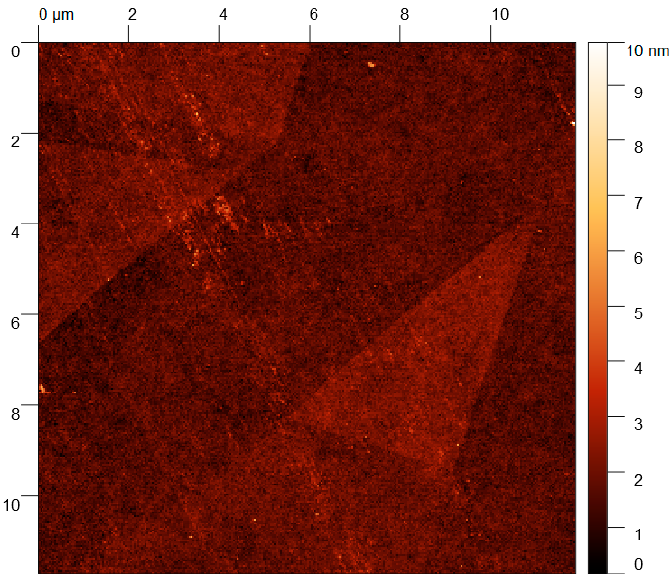
Figure 3. Image from AFM of nanolayers obtained from Ga–Sn–Zn eutectic alloy on silicon.